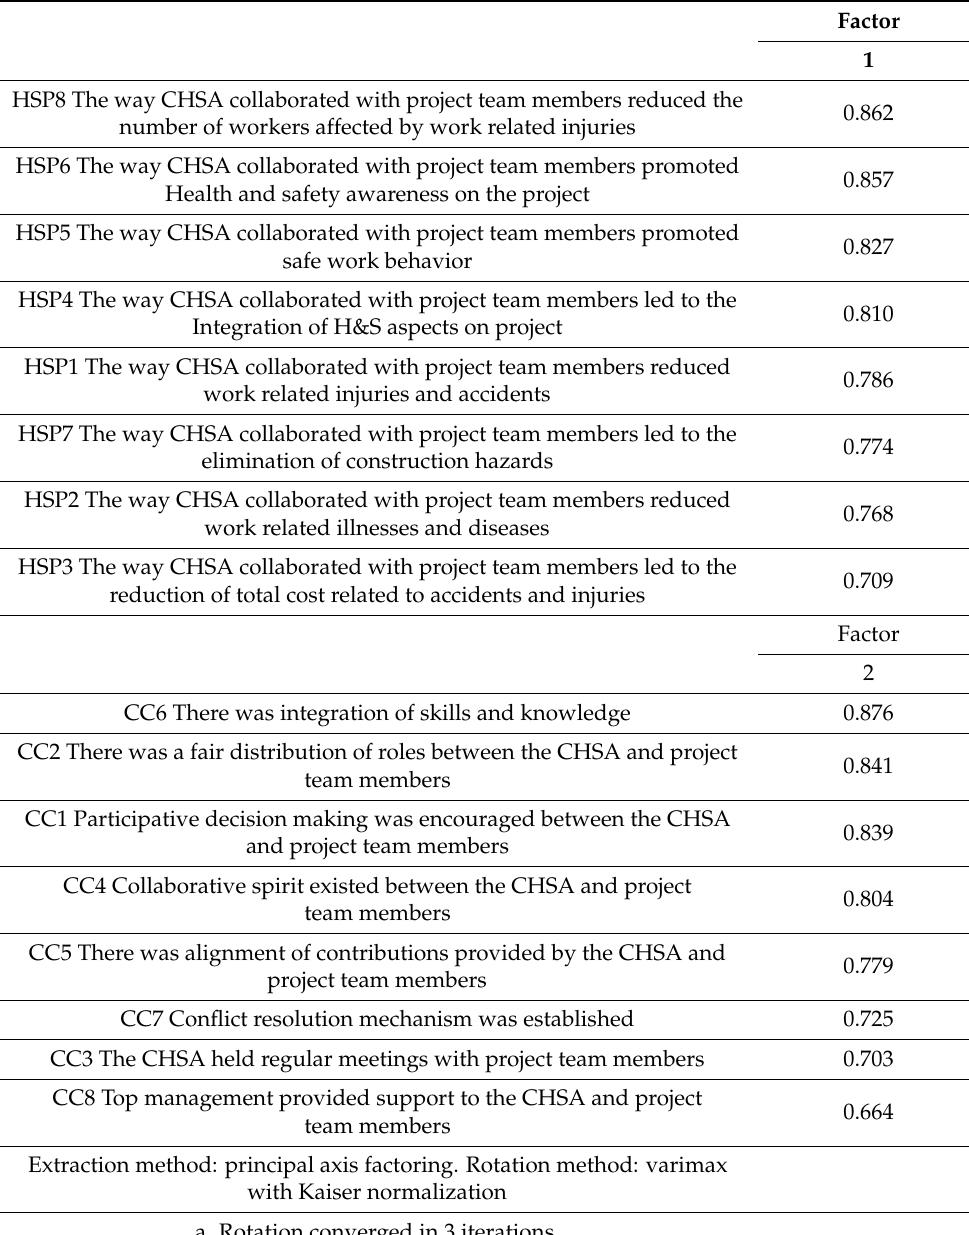
Table 8. Rotated factor